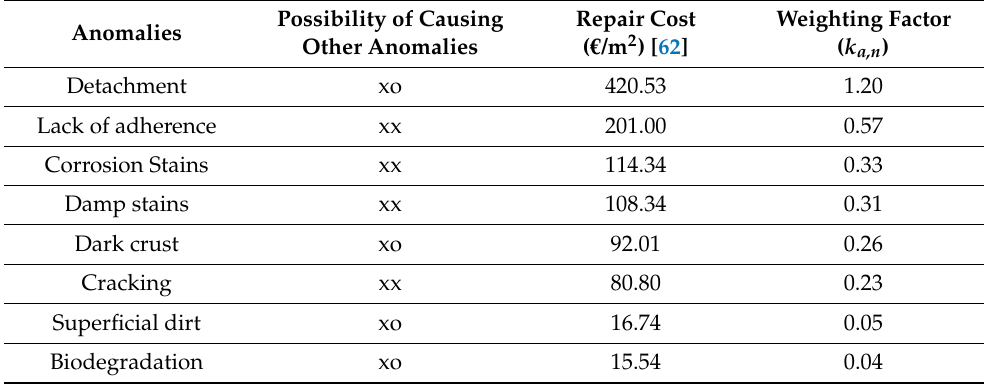
Table 5. Weighting factors ( k a,n ) linked to anomalies presented in the case